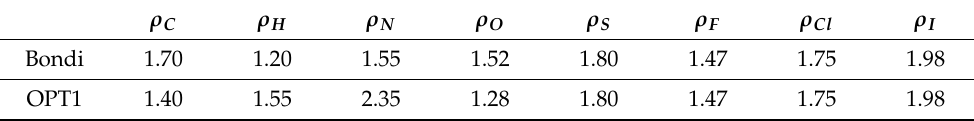
Table 1. Two sets of atomic radii in Å used in this